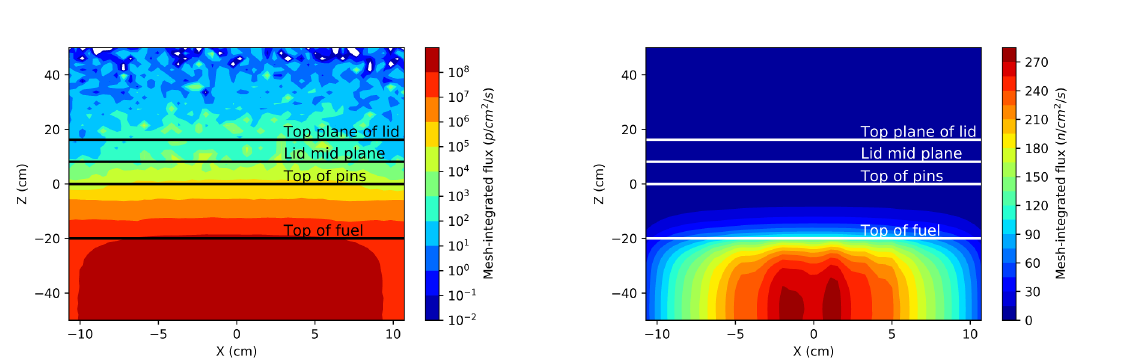
Figure 6: Left: Mesh-integrated gamma flux (for energies 600-800 keV). Right: Mesh-integrated neutron flux (for energies 0-14 MeV). Averaged over the